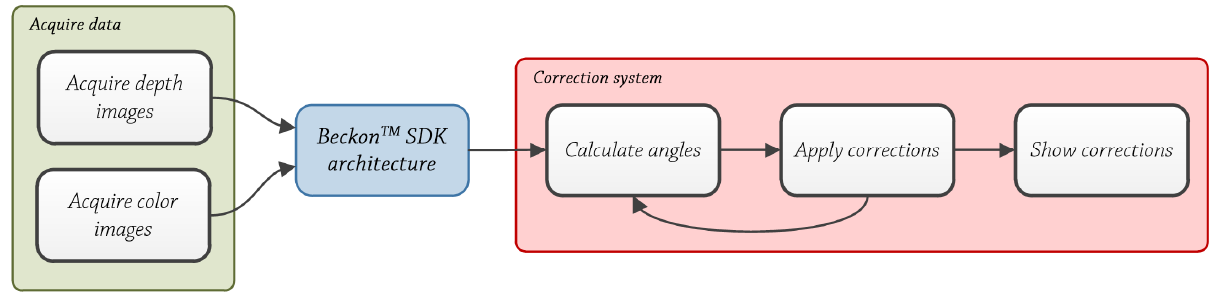
Figure 4. Correction system block